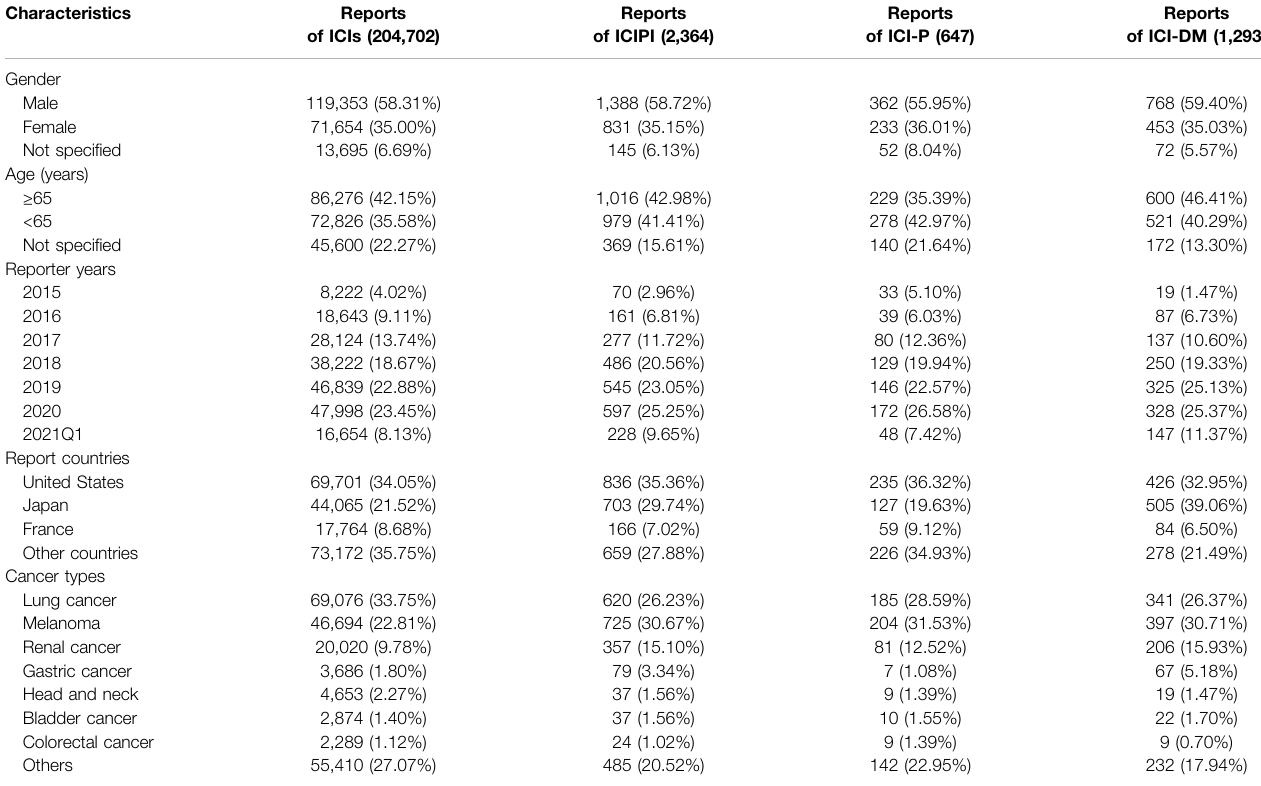
TABLE 1 | Clinical characteristics of patients with ICI-associated pancreatic AEs.